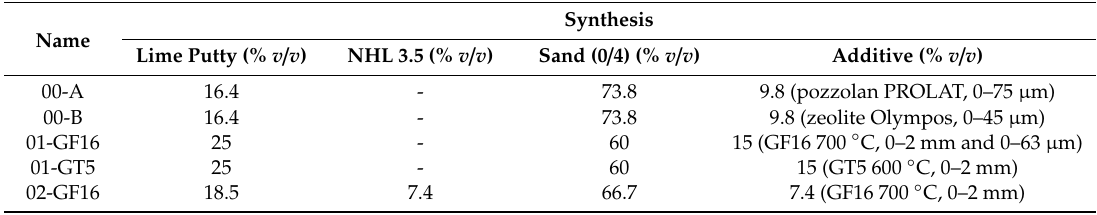
Table 1. Proposed mix designs.